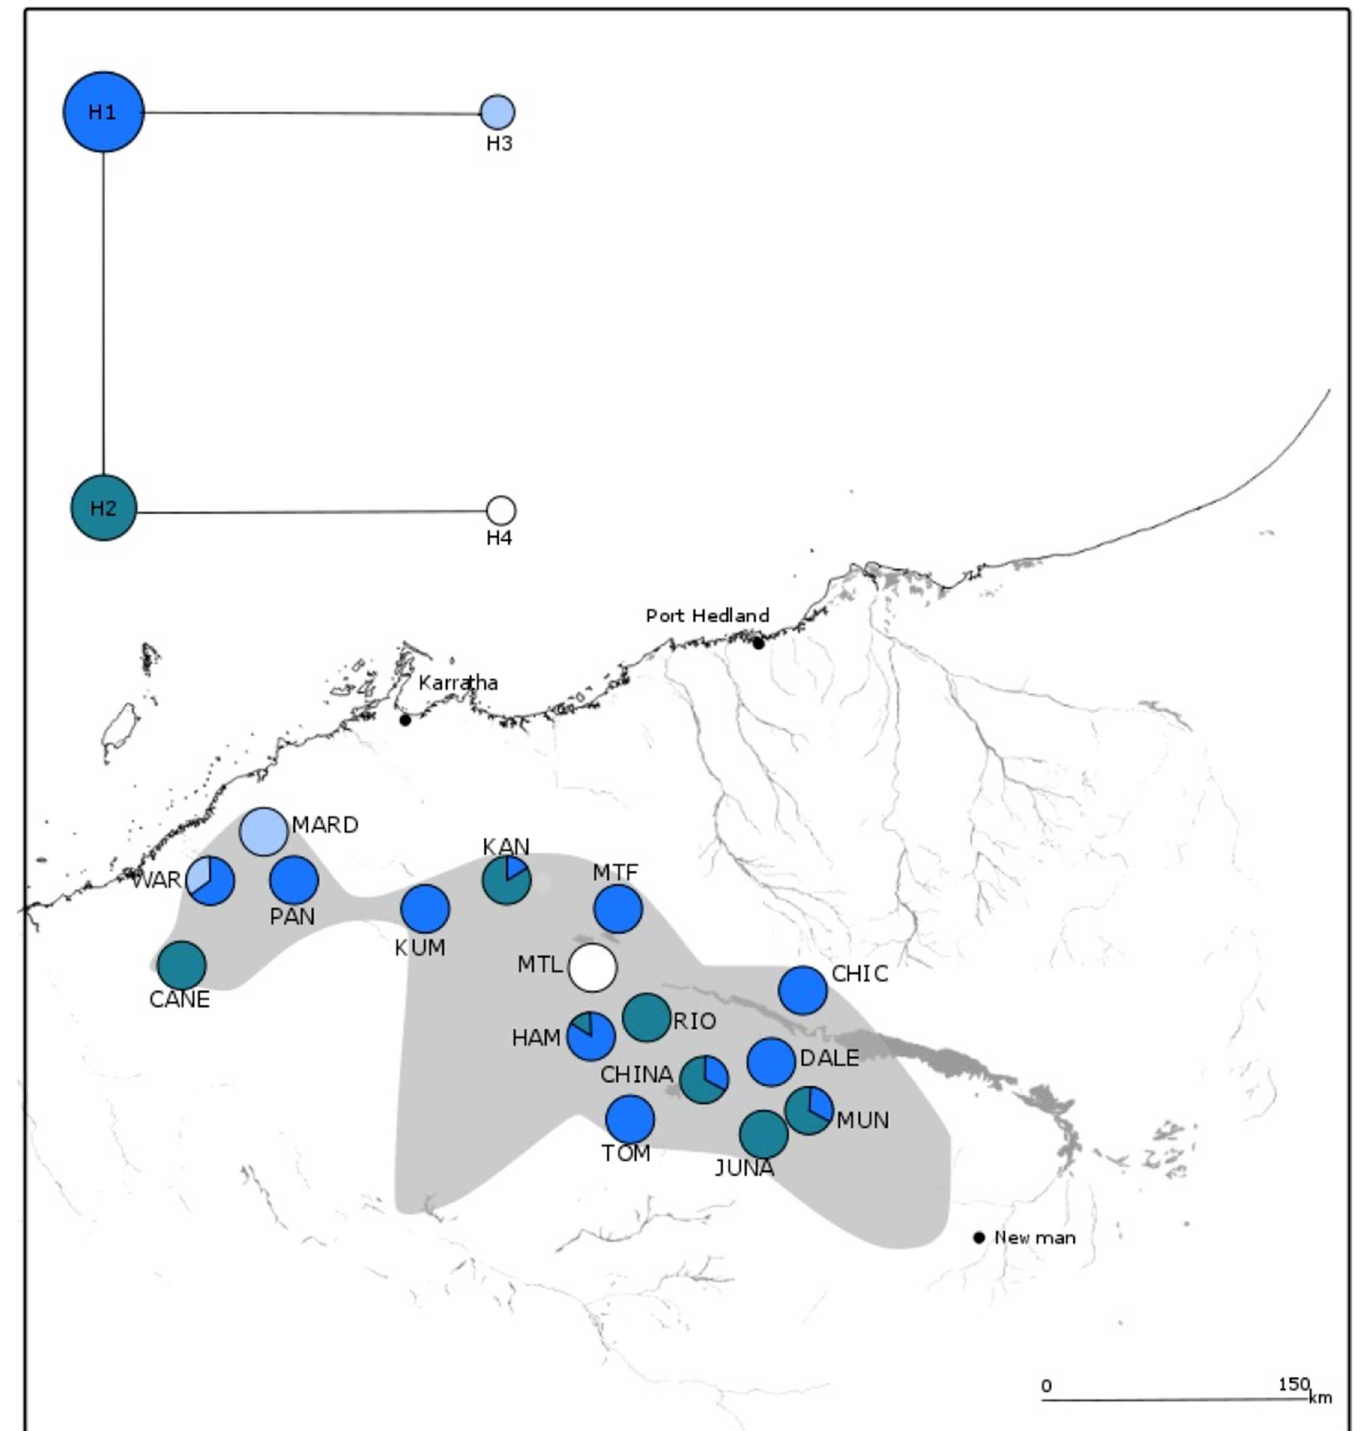
Fig 2. Geographical distribution of populations and chloroplast haplotypes for Acacia ancistrocarpa . The species distribution is shown in grey. All chloroplasthaplotypesfound in each populationare shown with section sizes indicatingthe proportion of individualswith that haplotype.The haplotype network is shown in the upper left corner, each circle representsa distinct haplotypeand its size indicates its relative frequencyamongst all individuals. Branch length indicates the number of mutational steps between haplotypesand unobservedhaplotypes are represented by black circles. Major water courses and the Fortescue floodplainare